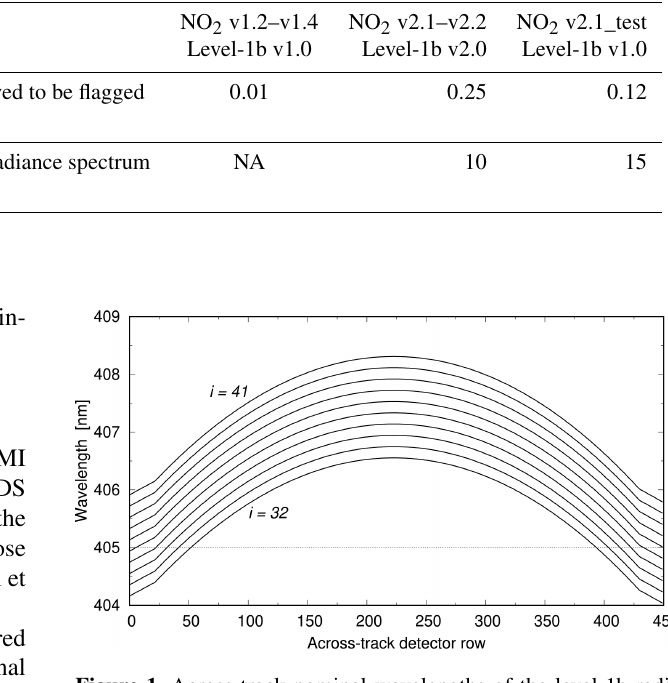
Figure 1. Across-track nominal wavelengths of the level-1b radi- ance spectra of v2.0 for a selected number of spectral indices: i = 32 to i = 41 of band 4. The horizontal dotted line marks